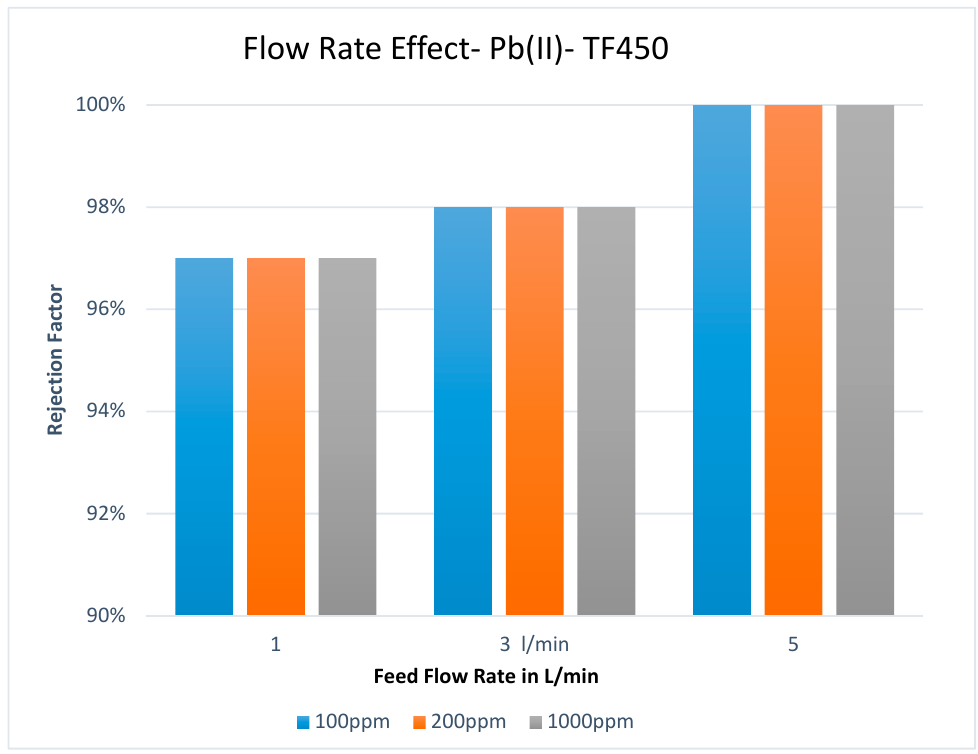
Figure 6. Effect of feed flow rate on the rejection factor using TF450 membrane for Pb(II) (feed temperature = 50 °C, condensing temperature = 10 °C).